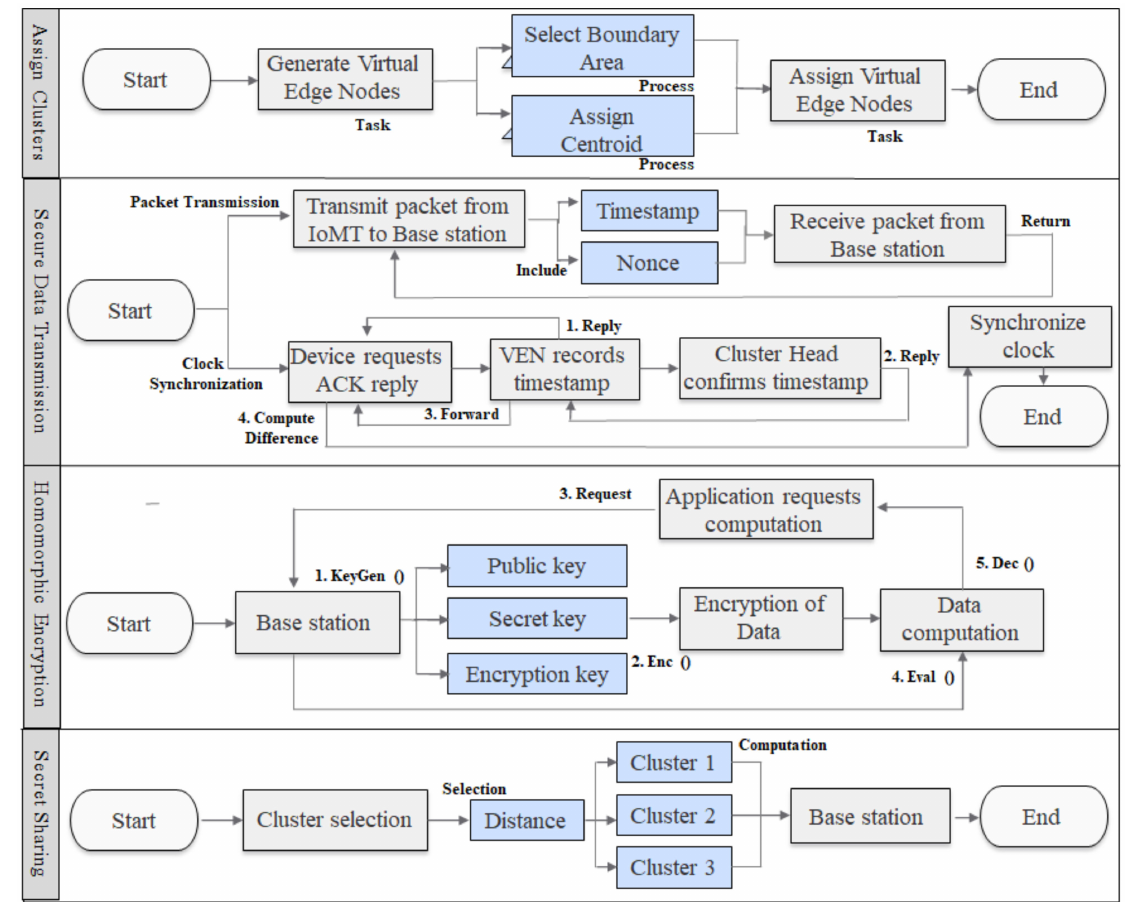
Figure 2. Workflow of the proposed